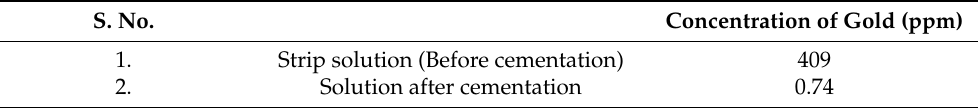
Table 6. Concentration of gold before and after cementation. S.